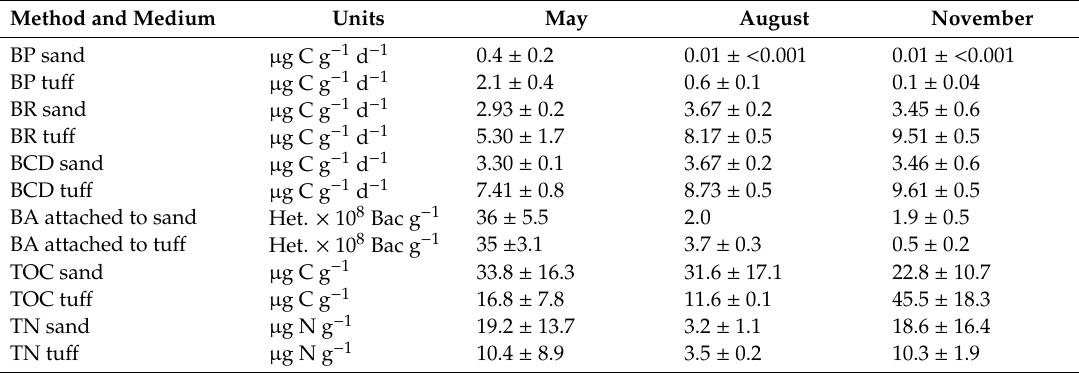
Table 1. Microbial and organic analysis of sand and tu ff media. Numbers are shown as averages (with corresponding standard deviations, STDV) of each quadruplicate